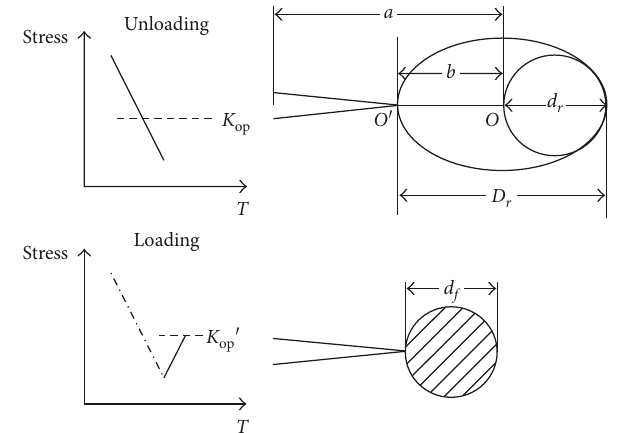
Figure 4: Schematic illustration of crack closure.